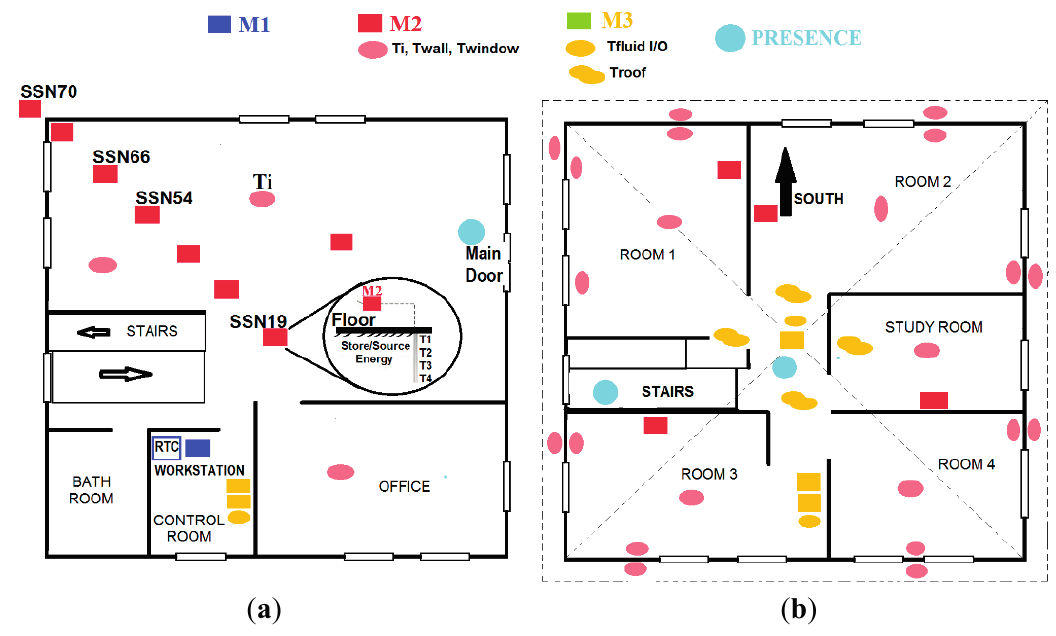
Figure 12. IoT nodes distribution in the nZEB. ( a ) Lower floor; ( b ) Upper floor. On the lower floor, M2 type IoT nodes (red square) are located at different ground depths (T1, T2, T3, and T4) to measure underground temperature (Figure 12a). Another M2 sensor (red circle) measures indoor temperature (Ti). On the upper floor, the M2 nodes measure indoor, walls and window